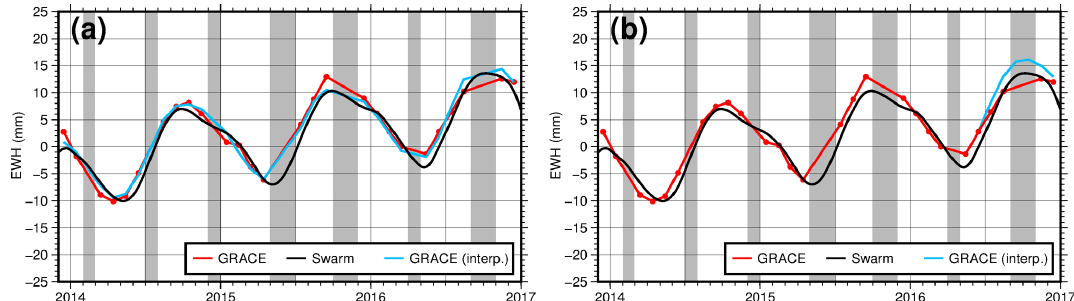
Figure 13. Bridging gaps with Swarm. Our IGG Swarm solution (black) is compared to the monthly GRACE solutions (red) as well as to interpolated values when we assume a part of the GRACE time series to be missing. (a) Each month is assumed to be missing and is interpolated from all other months. (b) The last 6 months are assumed to be missing and are interpolated from all other months.